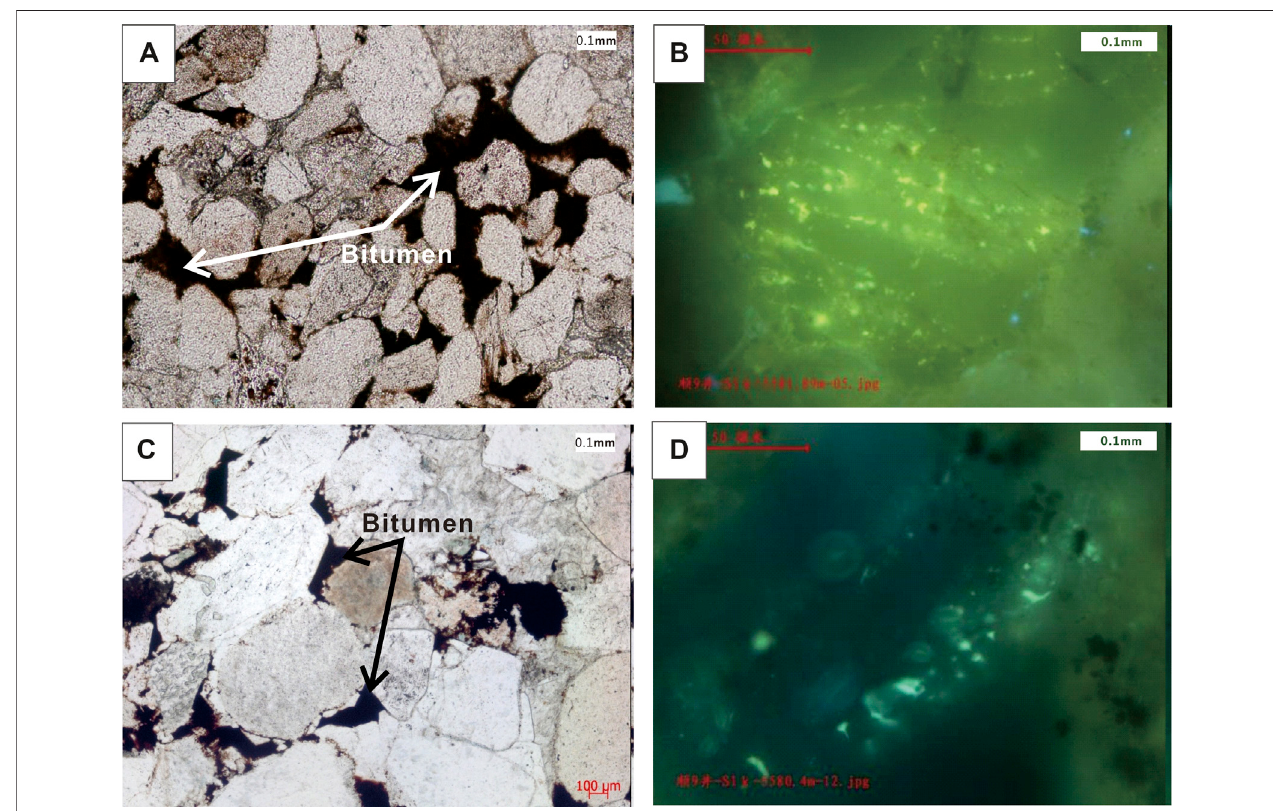
FIGURE 6 | Microphotography of reservoir bitumen and fl uorescent photography of inclusion (A) Bitumen fi lling along the corroded edge of the grains, Well Sh9, 5335.79m, 10 × 10 (-) (B) The hydrocarbon inclusions developed in quartz grains with a beaded distribution in the cracks, displaying yellow fl uorescence, fi ne grayish sandstonewithoily spots, WellSh9, 5581.89m. (C) Bitumen fi llingintothe dissolved pores ofcalcite cement later than quartz overgrowth,WellSh9, 5476.48m, 10 × 10 (-). (D) The hydrocarbon inclusions develop in quartz grain cracks, which are scattered and uneven in size, displaying bluish-green fl uorescence, fi ne grayish sandstone with oily spots, Well Sh9,